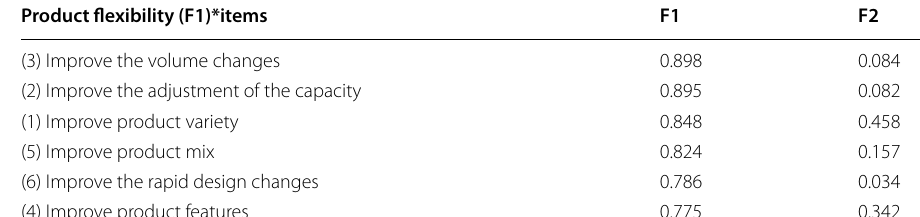
Table 3 Rotated component matrix for supply chain